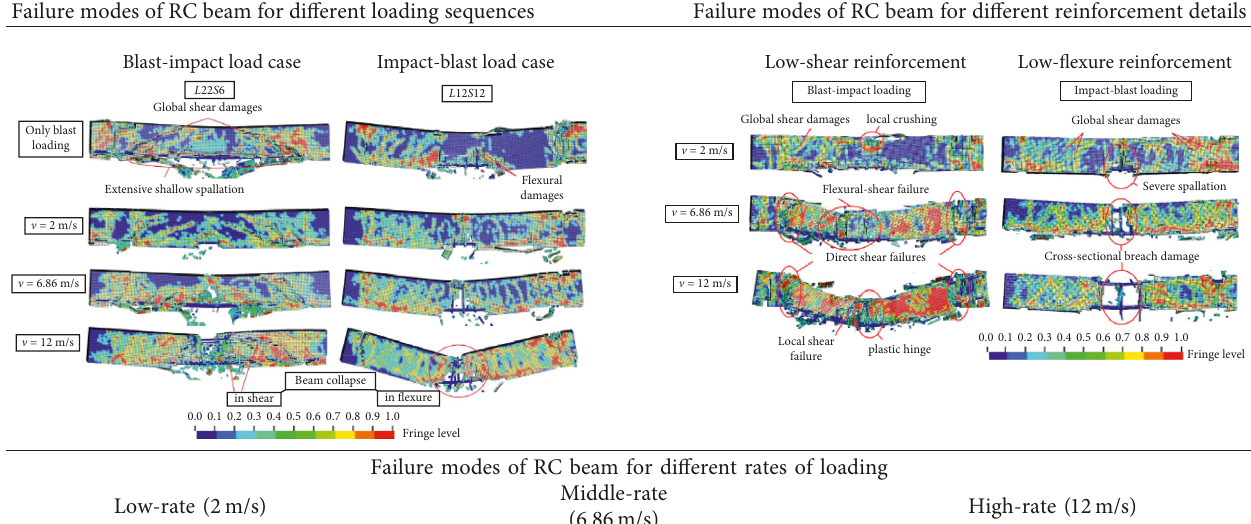
Table 3: Summary of FEA numerical simulation failure modes for RC beam under combined blast and impact loads [8]. Failure modes of RC beam for different loading